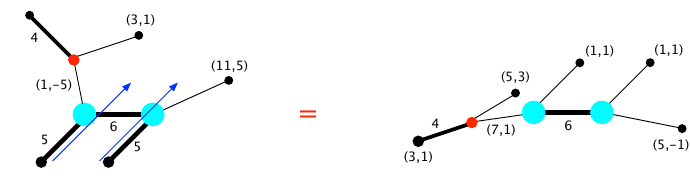
Figure 10 . Equivalent webs for SU(6) 6 with a massive antisymmetric